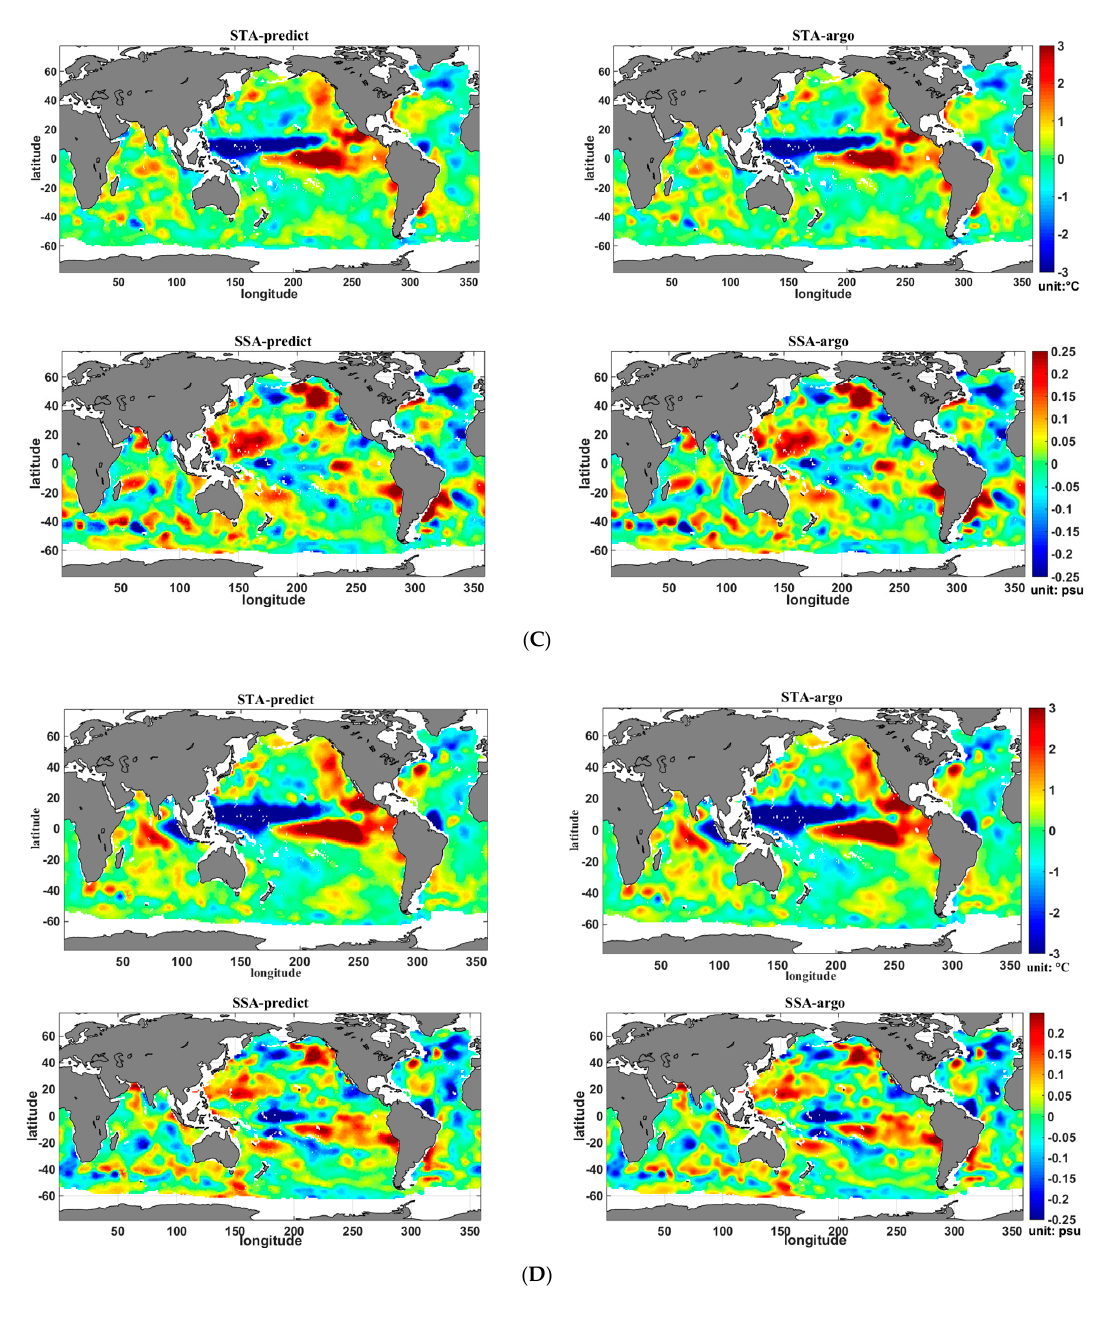
Figure 3. Spatial distribution of STA and SSA from the XGBoost-estimated results and the Argo data at 100 m for the different seasons in 2015: ( A ) January, ( B ) April, ( C ) July, and ( D ) October. As Figure 3 shows, at 100 m, the STAs were all significantly positive in the central and eastern equatorial Pacific and negative in the western equatorial Pacific in the different seasons, while the SSAs show a comparatively even distribution pattern. The global ocean STAs were dominated by the strong El Niño phenomenon at the upper depth levels in 2015. At the same time, the temperature in the western equatorial Pacific Ocean was abnormally low, and the STA in the Indian Ocean presented a distribution pattern with positive values in the east and negative values in the west because the Indian Ocean dipole was in a positive phase period. Moreover, the El Niño phenomenon in the equatorial Pacific became increasingly stronger, with a Nino 3.4 index of 0.6 °C in January, 0.8 °C in